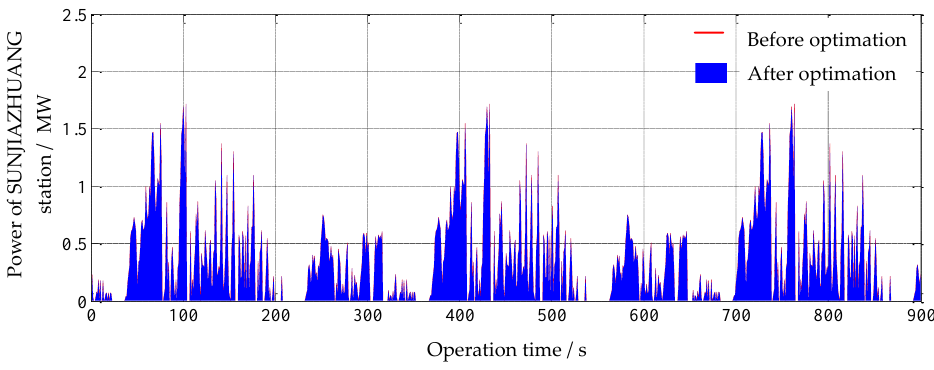
Figure 20. Power of Songjiazhuang’s substation before and after dwell time optimization.